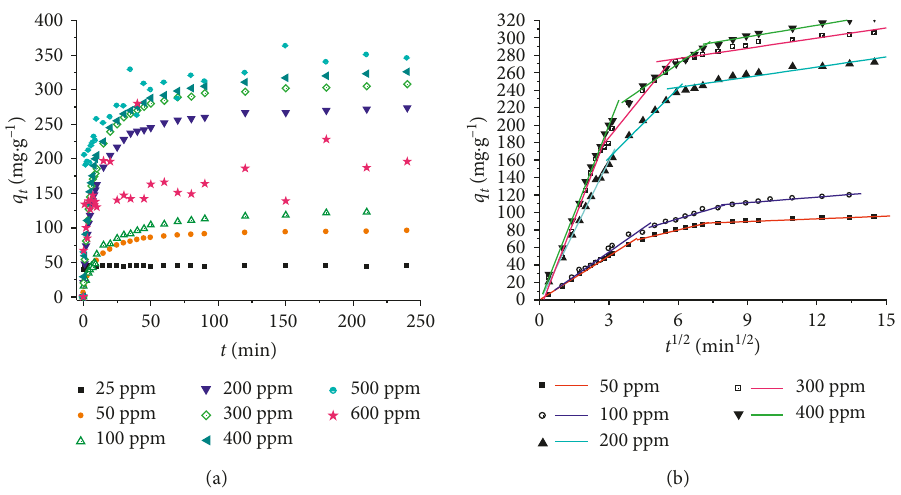
Figure 4: (a) RDB adsorption kinetics on MIL-101 at different concentrations; (b) stepwise lines of intraparticle diffusion plots for the adsorption of RDB on MIL-101 with different initial concentrations (adsorption condition: V temperature).